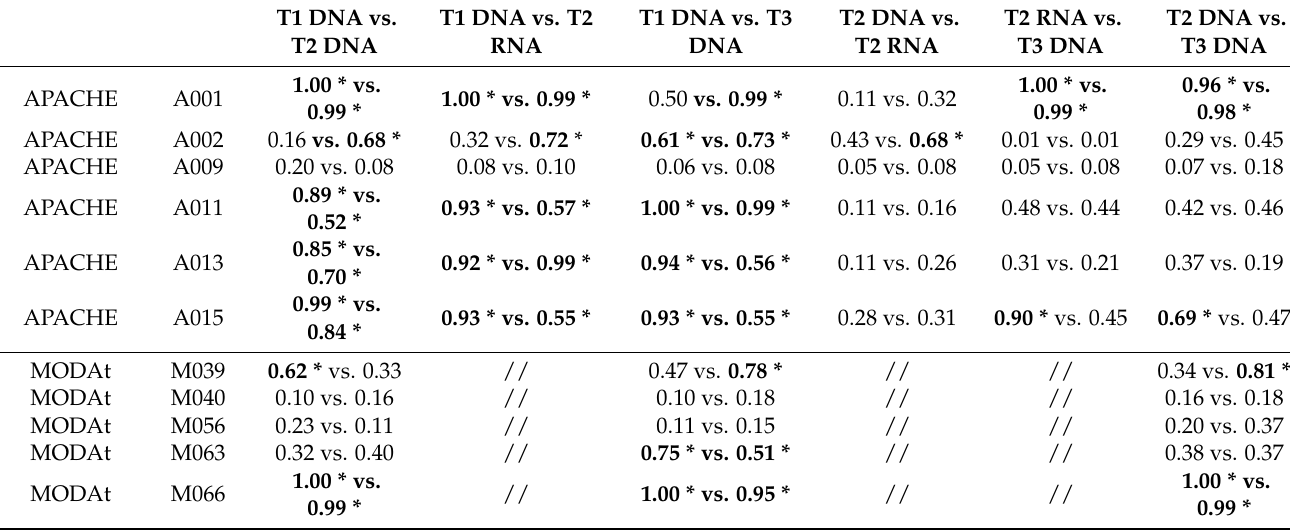
Table 3. Genealogical Sorting Indices for